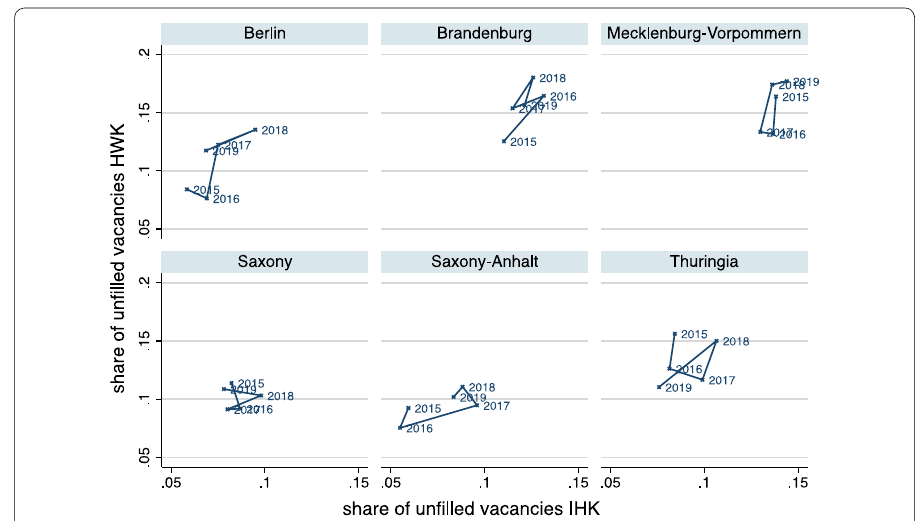
Fig. 15 Share of unfilled vacancies in craft (HWK) and industry and trade (IHK) for East German states, 2015– 2019. Data sources: Vocational training statistics of the statistical offices of the federal and state